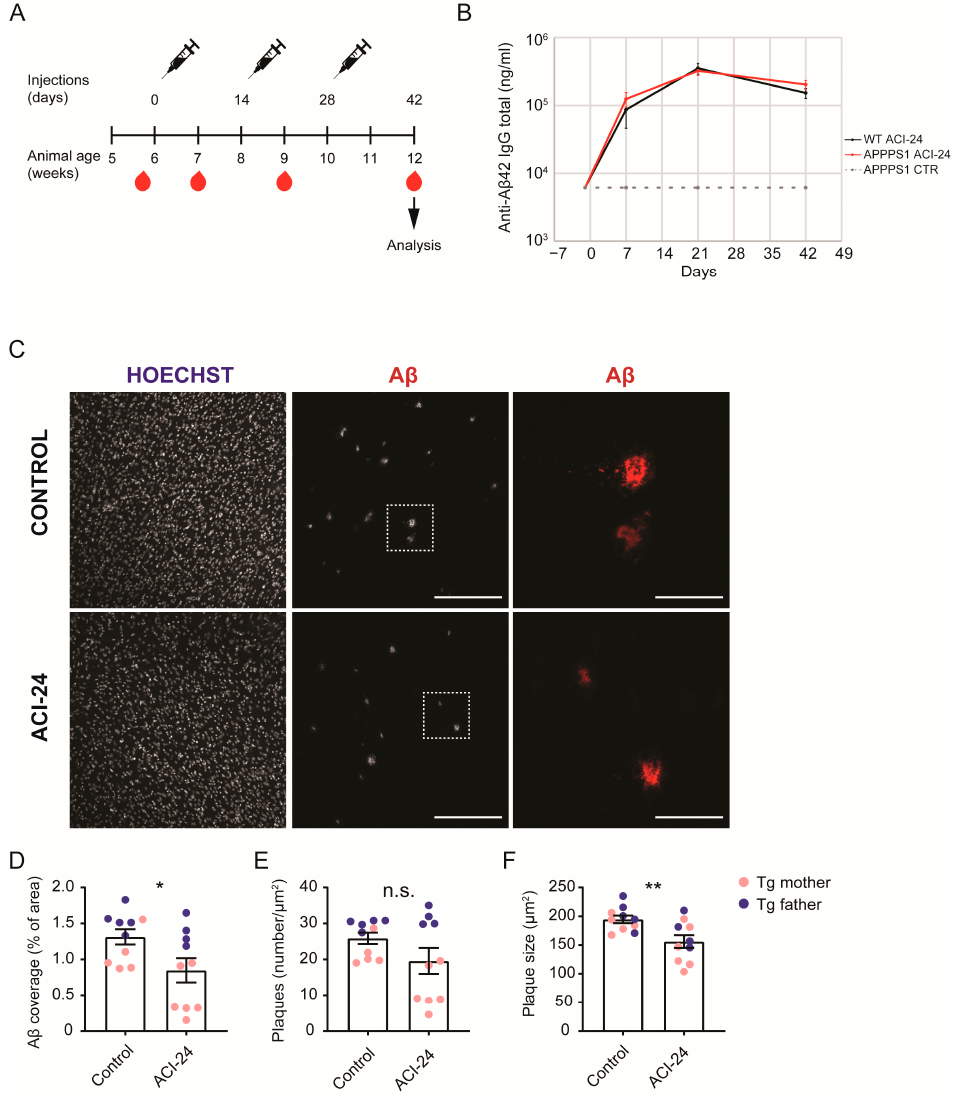
Figure 1. ACI-24 vaccination efficiently reduces A β plaque load in APPPS1 mice. Schematic overview of the vaccination paradigm ( A ). ELISA analysis of the anti-A β 42 total IgG titres (ng/mL) in plasma ( B ). Control APPPS1 mice (PBS treated, in dotted grey) have the baseline titres, while both ACI-24 vaccinated APPPS1 (in red) and ACI-24 vaccinated WT mice (in black) have robust and sustained immune response. Representative images of A β (as stained with NAB228 antibody) and nuclei (Hoechst) in cortical sections show decreased A β deposition following ACI-24 vaccination. Scale bar for images in the centre column is indicating 200 μ m, and scale bar for images in the right column (magnification of dotted boxed regions from centre column images) is indicating 50 μ m ( C ). Statistical analysis of 10 control and 10 ACI-24 vaccinated APPPS1 mice for A β plaque coverage ( D ), number ( E ) and size ( F ). ACI-24 significantly downregulated A β plaque coverage and size. Offspring are from the transgenic mother (pink circles) or father (blue circles). Graphs are presented as mean ± SEM (* p < 0.05, ** p < 0.001, unpaired two-tailed Student’s t -test).